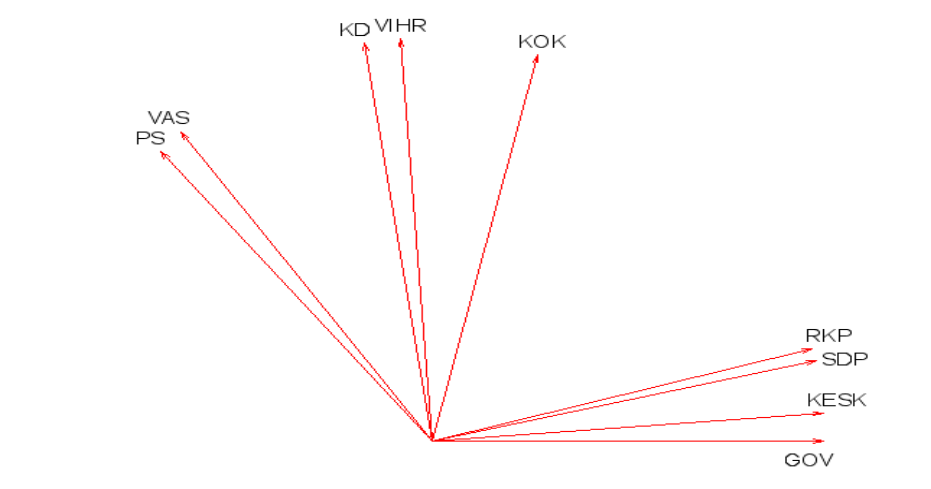
Figure 2d. Government and opposition voting during the Vanhanen I government